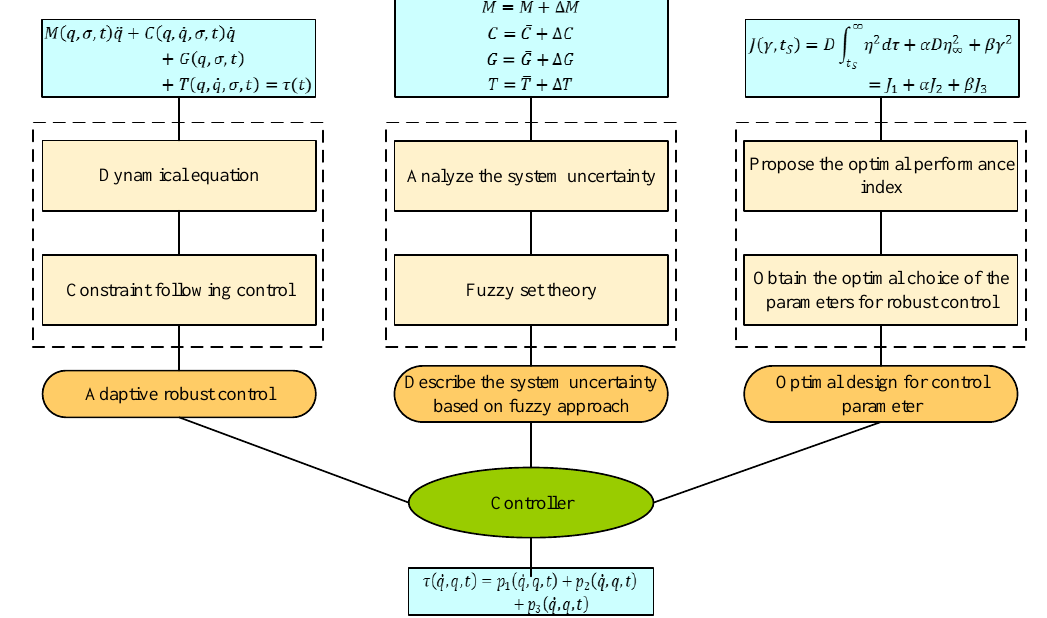
Figure 12. Optimal, adaptive, robust control design.